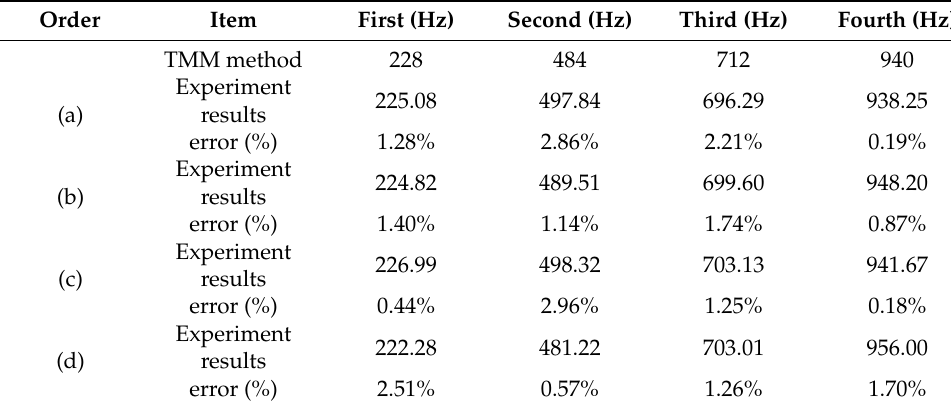
Figure 16. Velocity responses of pipe (case 4). ( a ) Axial velocity of point A. ( b ) Radial velocity of point A. ( c ) Axial velocity of point B. ( d ) Radial velocity of point B. Table 12. Resonant frequencies of pipe (case 4). Table 10. Resonant frequencies of pipe (case